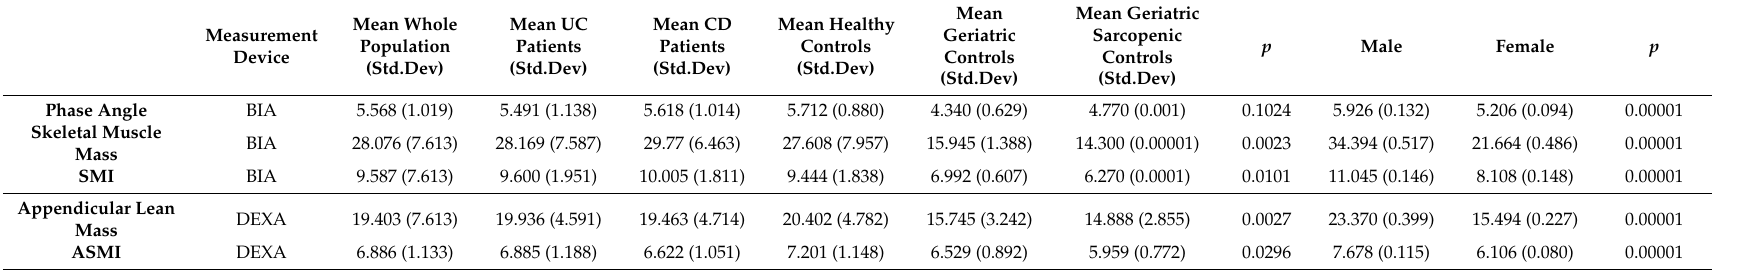
Table 2. Biometric evaluation: parameters by measurement device.